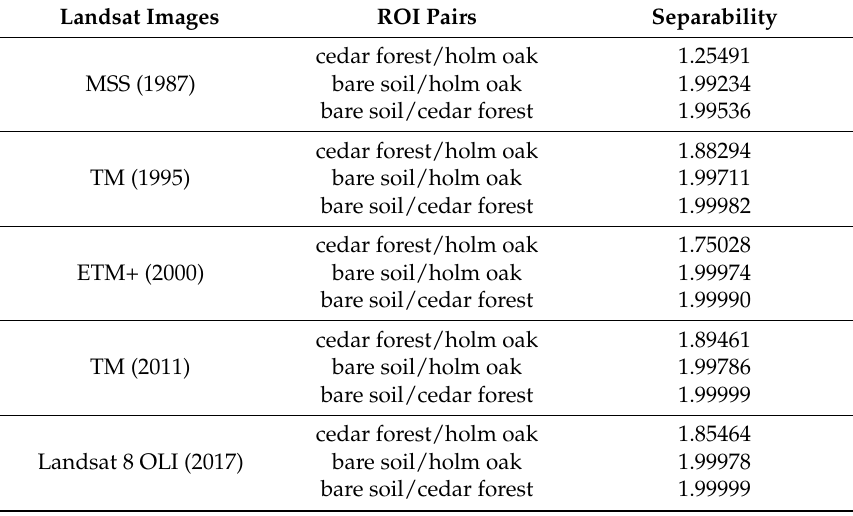
Table 3. ROI (region of interest) pairs’ separability (Jeffries–Matusita distance) between classes. Landsat Images ROI